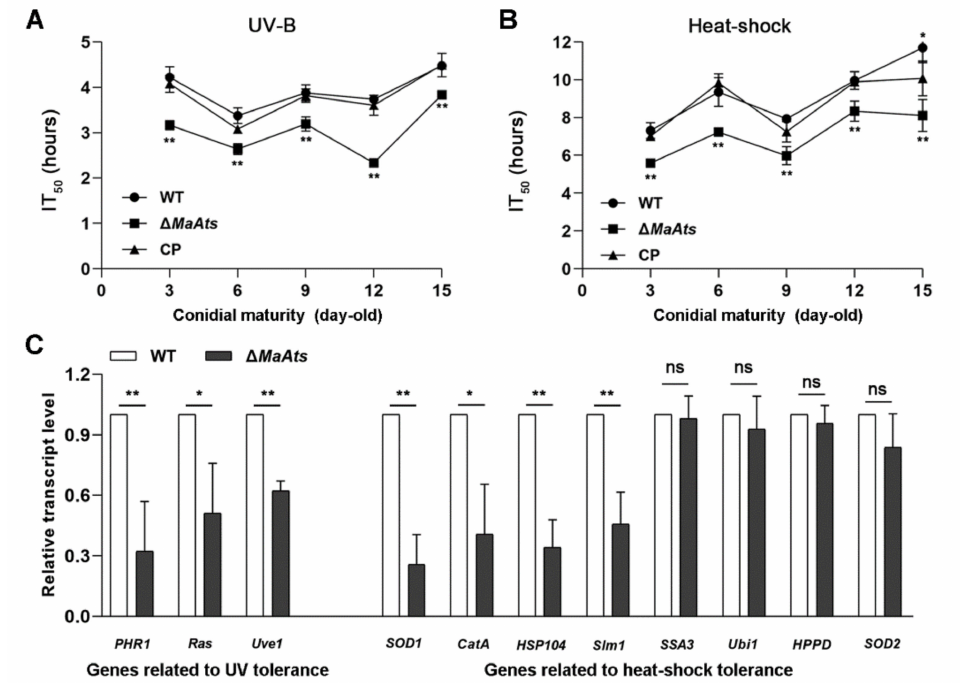
Figure 5. The deletion of MaAts diminished the UV-B irradiation and heat-shock tolerances of the conidia with different maturity. ( A ) The IT 50 of conidia with different maturity (3, 6, 9, 12 and 15-day-old) under UV-B irradiation. ( B ) The IT 50 of conidia with different maturity (3, 6, 9, 12 and 15-day-old) under heat-shock. ( C ) Relative transcript level of genes related to conidia tolerances to UV or heat-shock in the 3-day-old conidia. MaPHR1 (MAC_05772); MaRas (MAC_07622); MaUve1 (MAC_07337); MaSOD1 (MAC_03040); MaCatA (MAC_09645); MaHsp104 (MAC_05034); Maslm1 (MAC_04714); MaSSA3 (MAC_02927); MaUbi1 (MAC_01946); MaHPPD (MAC_02015); MaSOD2 (MAC_01660). Asterisk indicates significant difference at (**) p < 0.01, (*) p < 0.05, (ns) p >